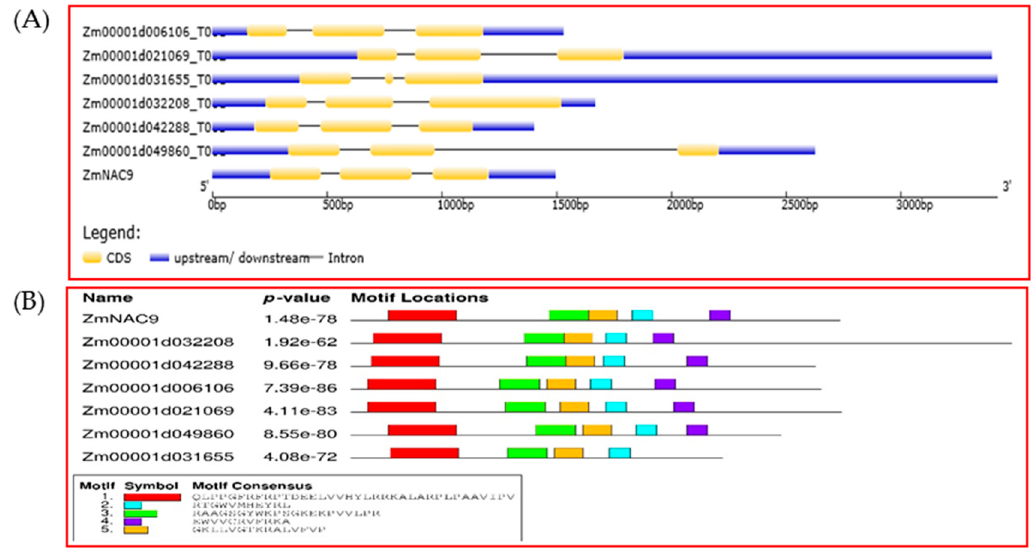
Figure 2. The gene structure and conserved domain of maize 7 genes. ( A ) Untranslated and exons are represented in blue and yellow boxes while introns are presented by blank line. ( B ) Conserved domains are presented in different color boxes.